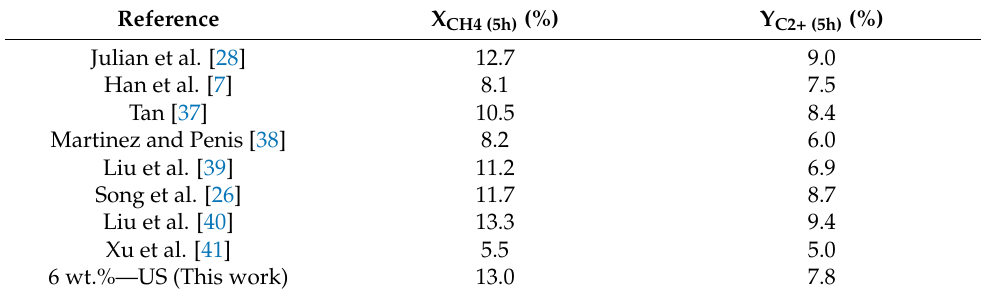
Table 4. Comparison of 6% Mo/ZSM-5 catalyst prepared with ultrasound with previous MDA results reported in literature on fixed beds of 5–6% Mo/ZSM-5 prepared by different methods.